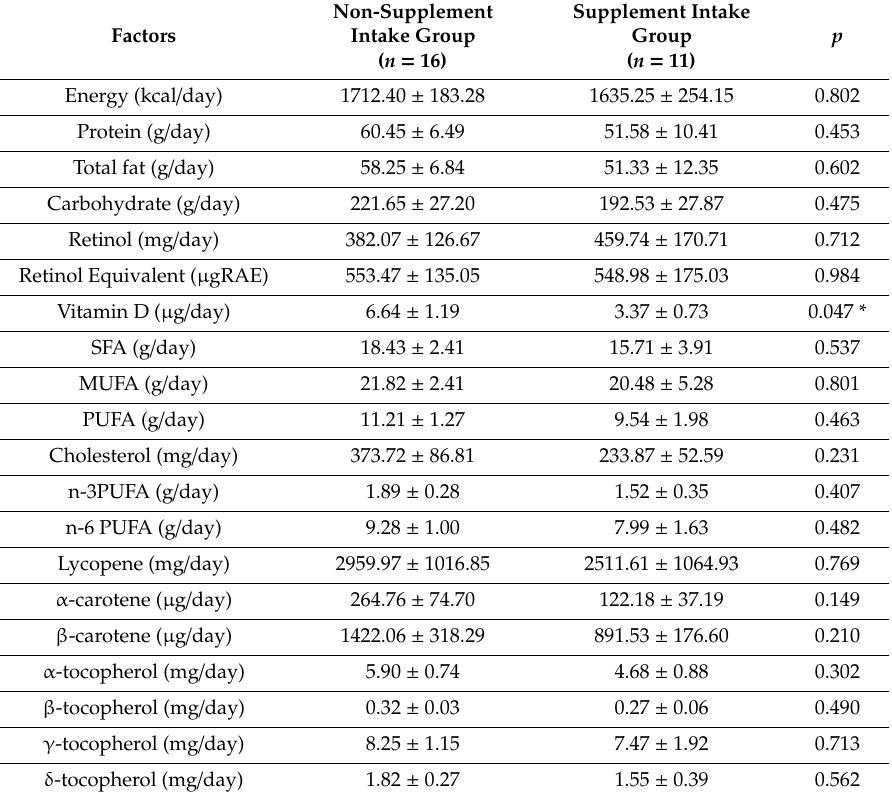
Table 6. Ingestion Frequency Investigation with or without antioxidative supplement